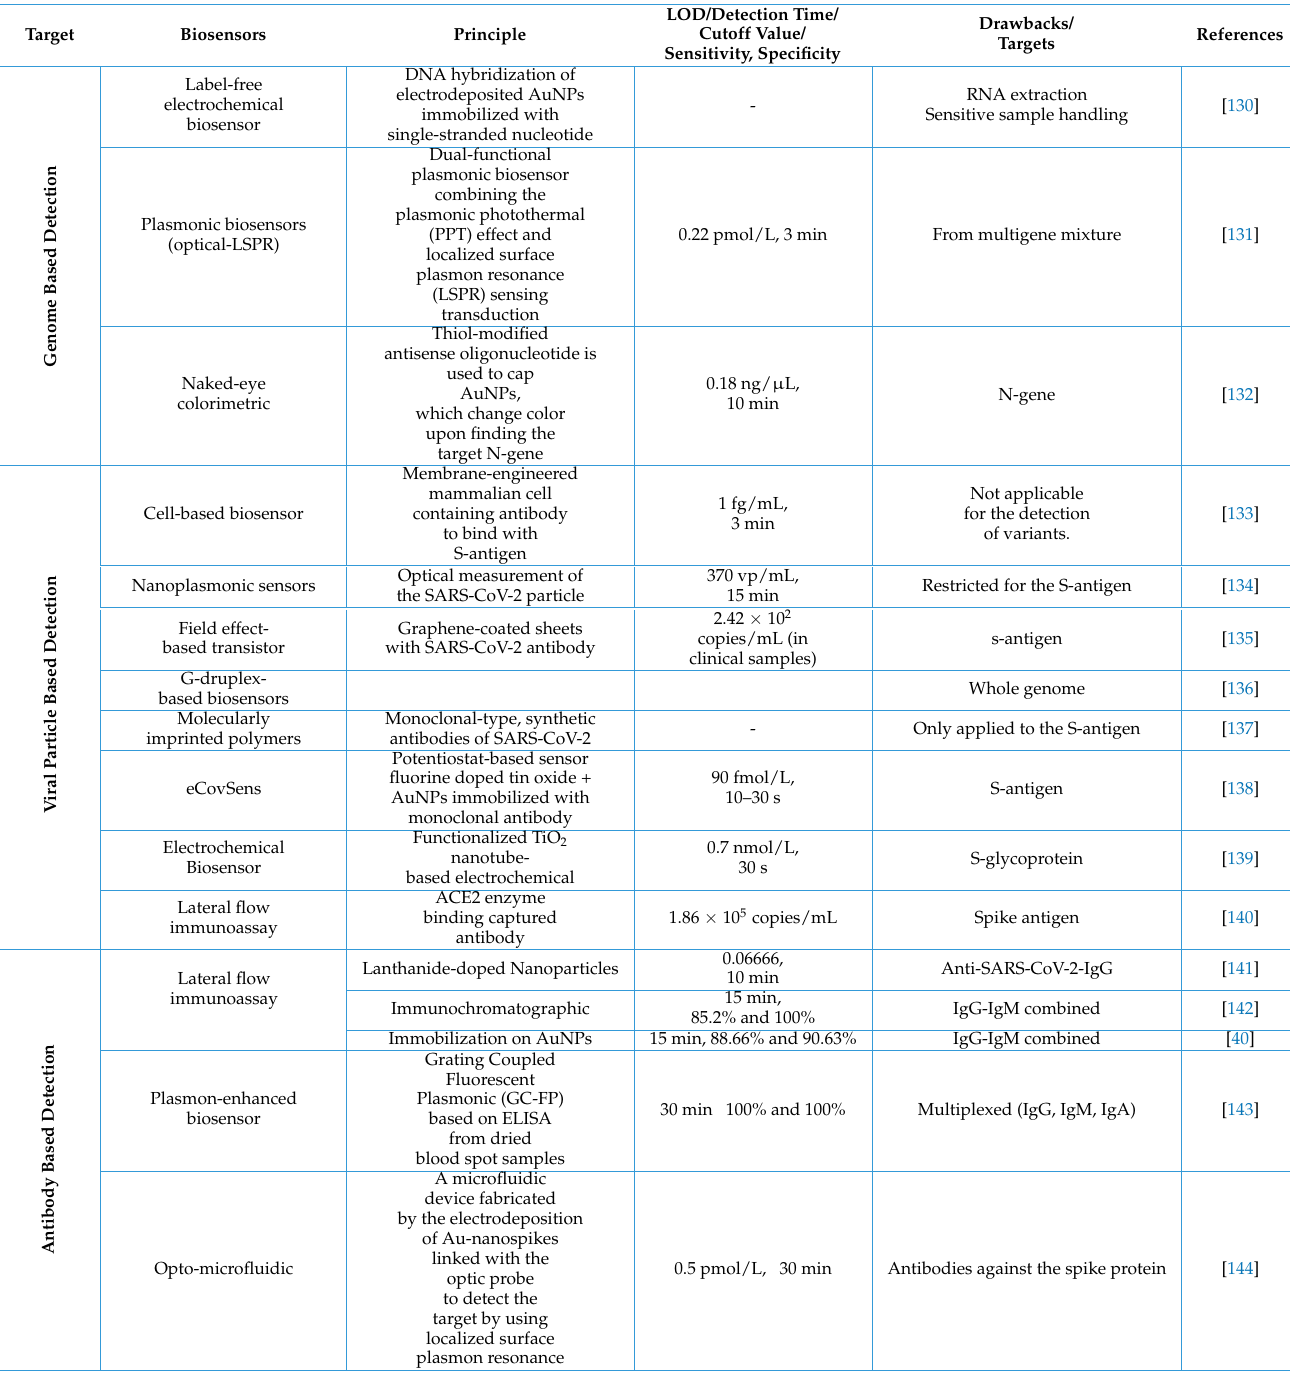
Table 2. Developed biosensors for the detection of